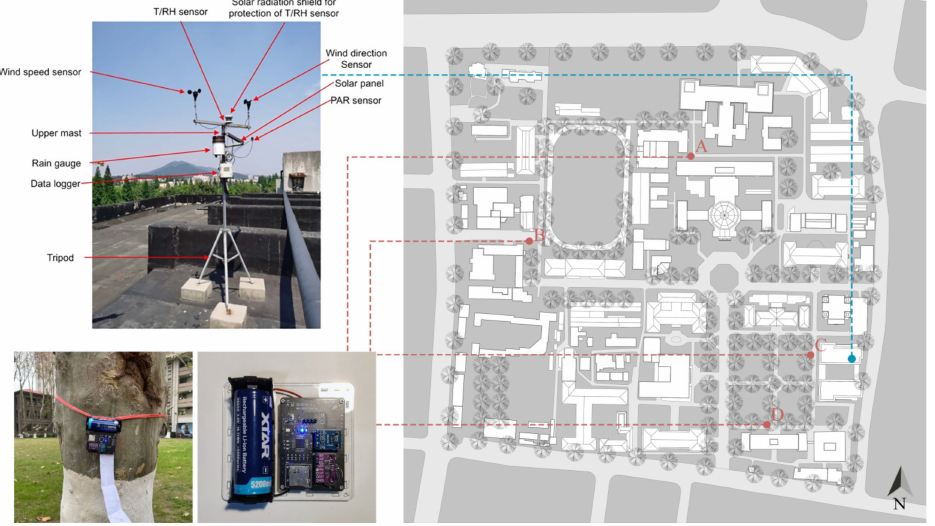
Figure 3. Location of SEU weather station, schematic map of measurement points, and photos of